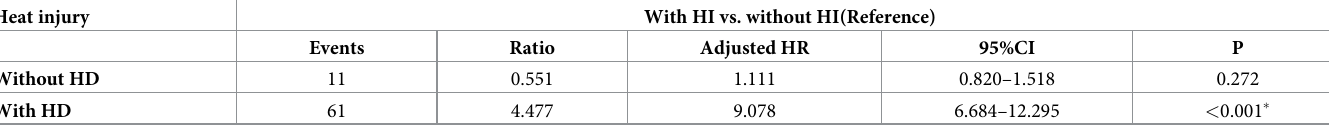
PYs = Person-years; Adjusted HR = Adjusted Hazard ratio: Adjusted for the variables listed in Table 2.; CI = confidence interval; ESRD = End stage renal disease; CKD = chronic kidney disease; HD = Hemodialysis; with HD represents heat injury patients with CKD and HD; without HD represents heat injury patients with CKD but without HD; ratio represents the risk of ESRD in HI vs non-HI.